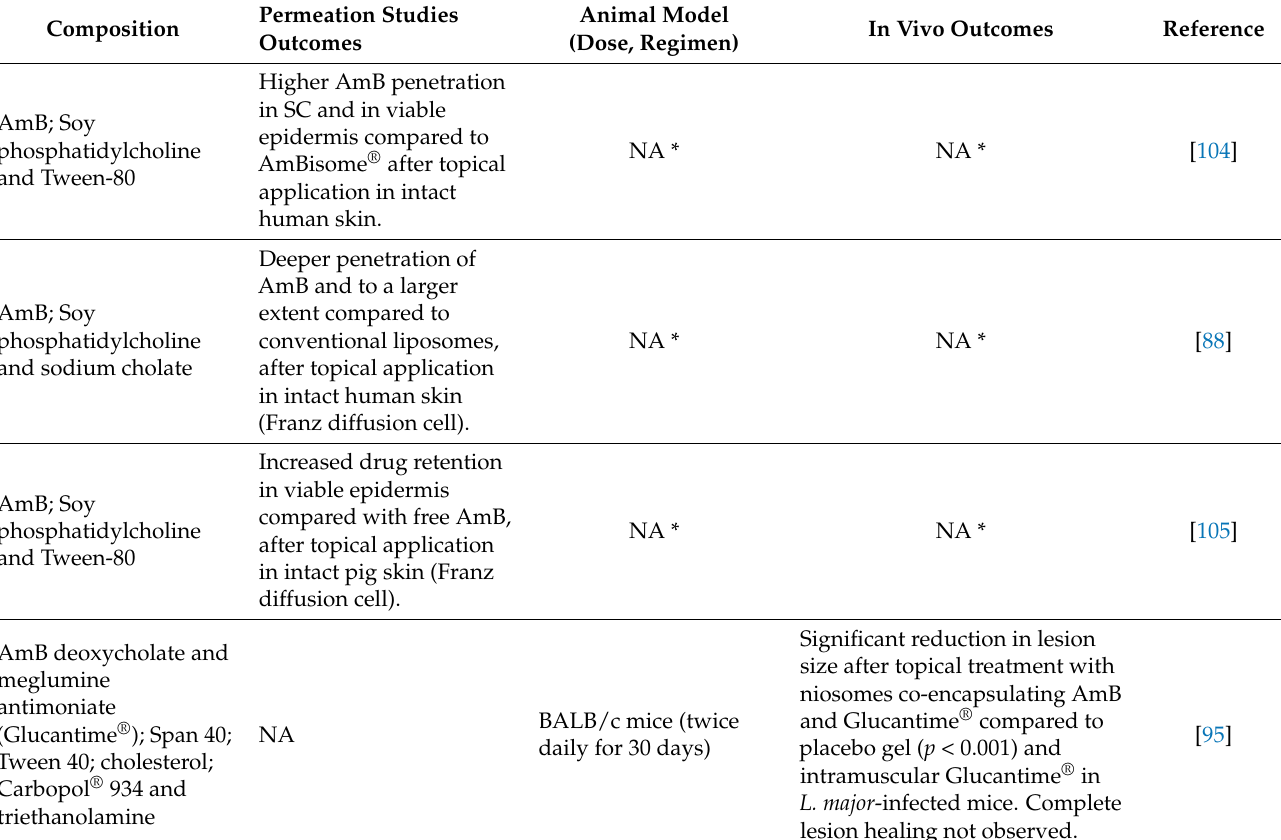
Table 2. Main experimental studies of AmB-loaded liposomes to treat